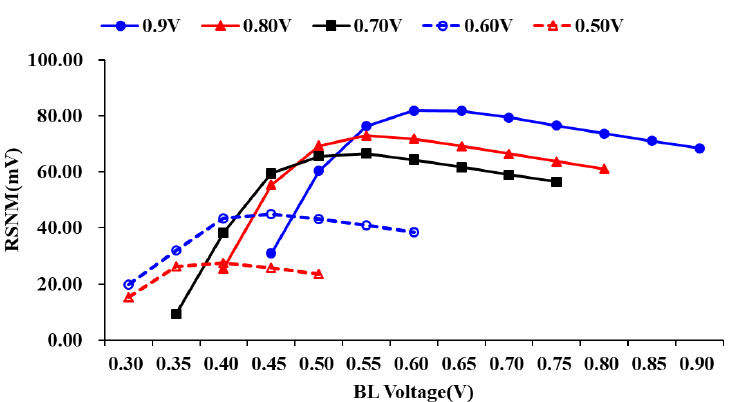
Figure 4. The RSNM simulation results of 6 T SRAM for pre-charge voltage adjustment. The comparison of RSNM simulation result of proposed local bit-line SRAM and conv. 6 T SRAM at the various operating voltages is shown in Figure 5. The RSNM memory cell curve decreased for low voltages. The proposed local bit-line SRAM has obtained strong RSNM by using low-voltage pre-charged scheme during the read operation.